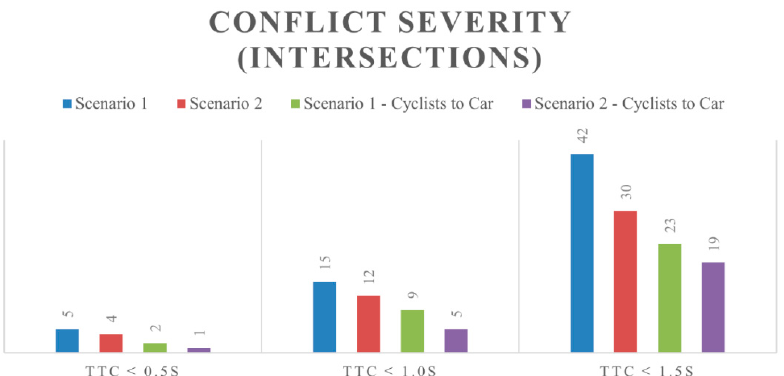
Figure 13. Number of conflicts by type in intersections.